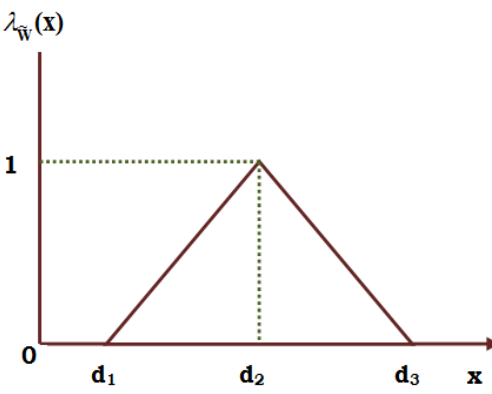
Figure 3. Membership function of a triangular fuzzy number.